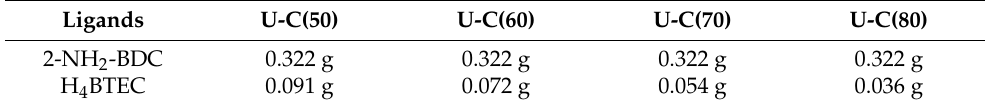
Table 1. Ligand ratios for the preparation of four kinds of UiO-66-(COOH) 2